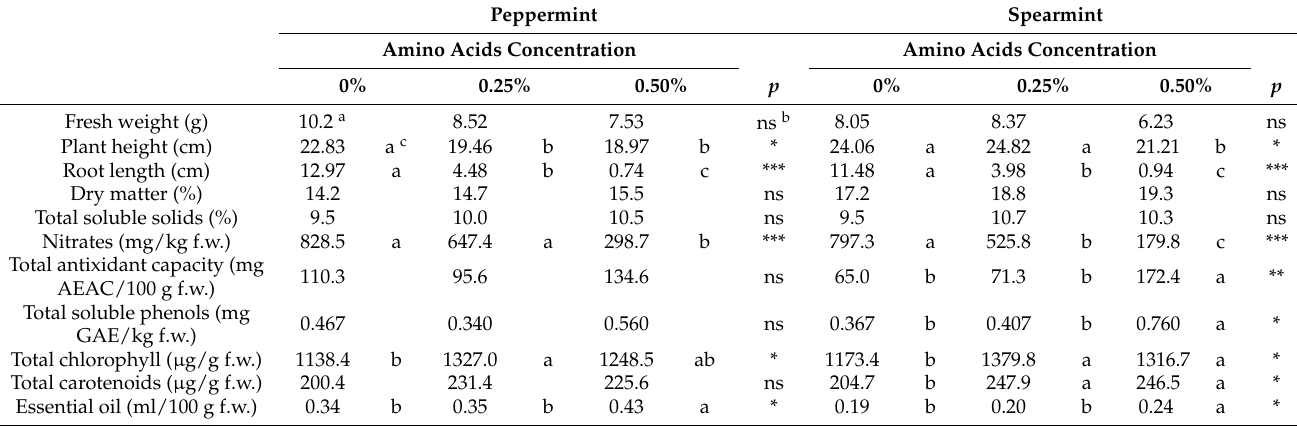
Table 1. Means of plant growth and nutritional composition characteristics of peppermint and spearmint plants grown in floating system in an NS in which 0, 0.25 or 0.50% of a commercial PH solution (Amino16 ® ) was added. Peppermint Spearmint Amino Acids Concentration Amino Acids Concentration 0% 0.25% 0.50% p 0% 0.25% 0.50% p Fresh weight (g)